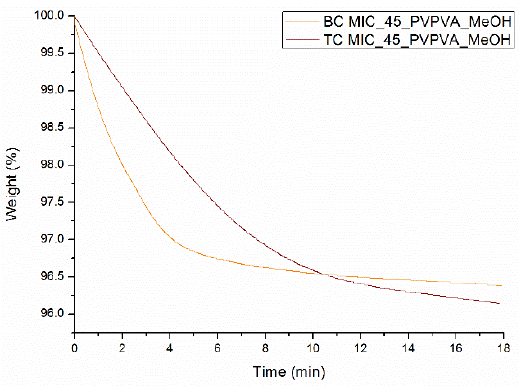
Figure 7. TGA curves of MIC_45_PVP-VA_MeOH systems prepared with bead coating (BC) and surface coating (TC).